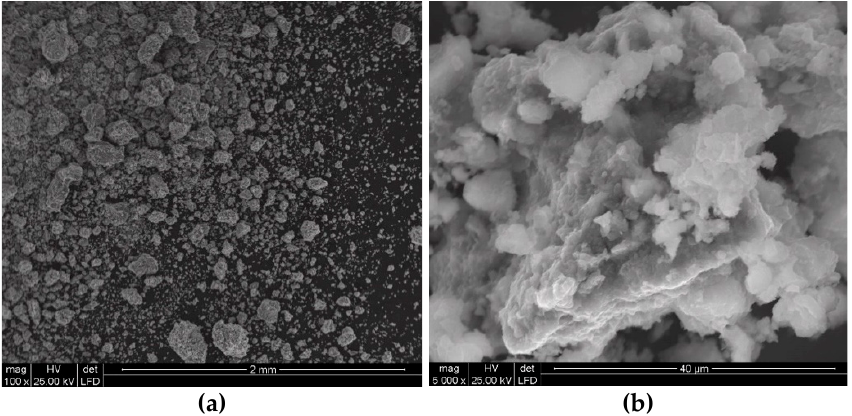
Figure 16. Example SEM images of concretion particles comminuted in a waterjet mill (for d w = 0.7 mm, d h = 2.4 mm, s = 10 mm, p = 200 MPa): ( a ) general view, ( b ) surface development.